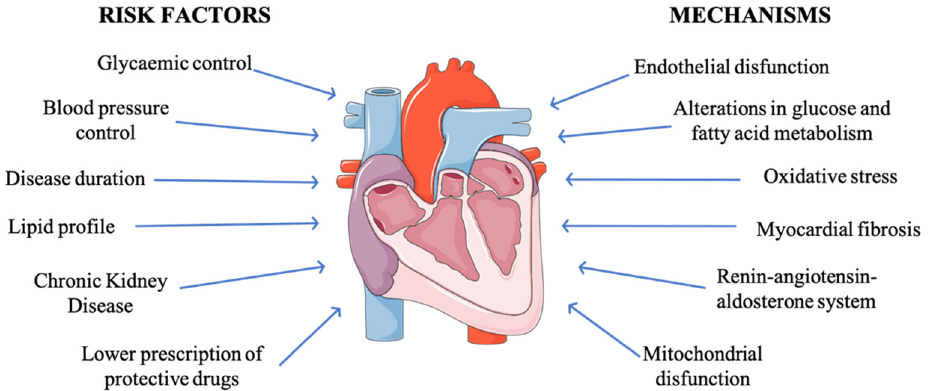
Figure 1. Risk factors and pathophysiology of heart failure in diabetes.